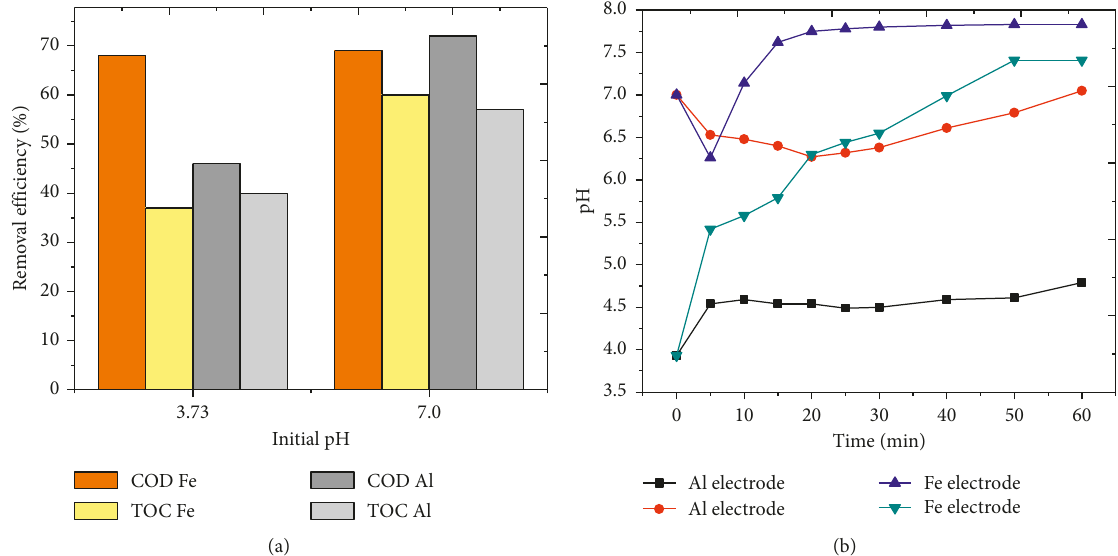
Figure 1: Effect of initial pH on the removal efficiency (a) and pH versus time for Fe and Al electrodes (b) at 28mA/cm 2 with electrolysis time of 60min for 1.0 L of S1